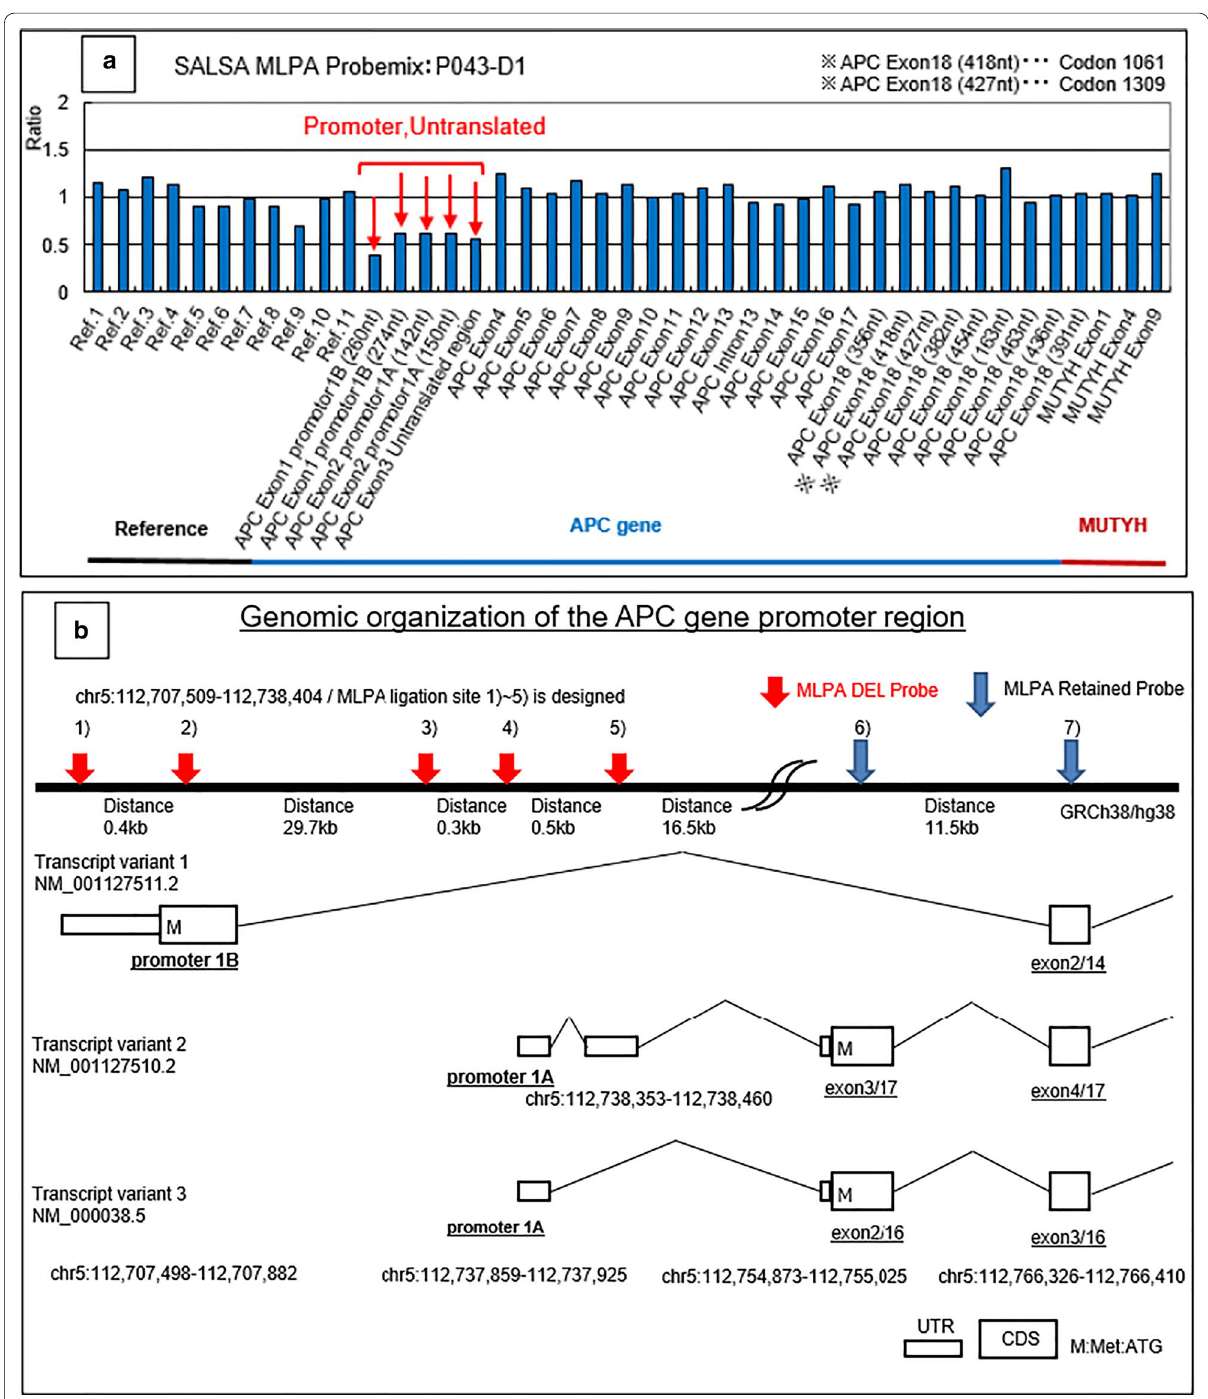
Fig. 6 Analysis by the multiplex ligation-dependent probe amplification technique. A decrease in the copy number of the promoter 1A and 1B region of the APC gene was revealed ( a ). Genomic organization of the promoter region of the APC genes and arrows indicate the positions of probes hybridizing the APC gene ( b